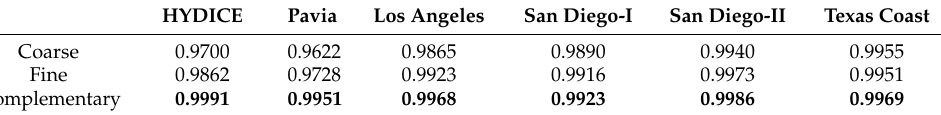
18 of 25 Figure 10. Histogram of the comparison results between the adaptive inner window–based method and dual rectangular windows–based method on experimental datasets. Here, “3”, “5”, “7”, “9” and “11” represent the size of inner window in dual rectangular windows, “AW” denotes the adaptive inner window. 4.4.2. Effectiveness Evaluation of Two-Stage Complementary Decision To validate the contribution of the proposed two-stage complementary decision for